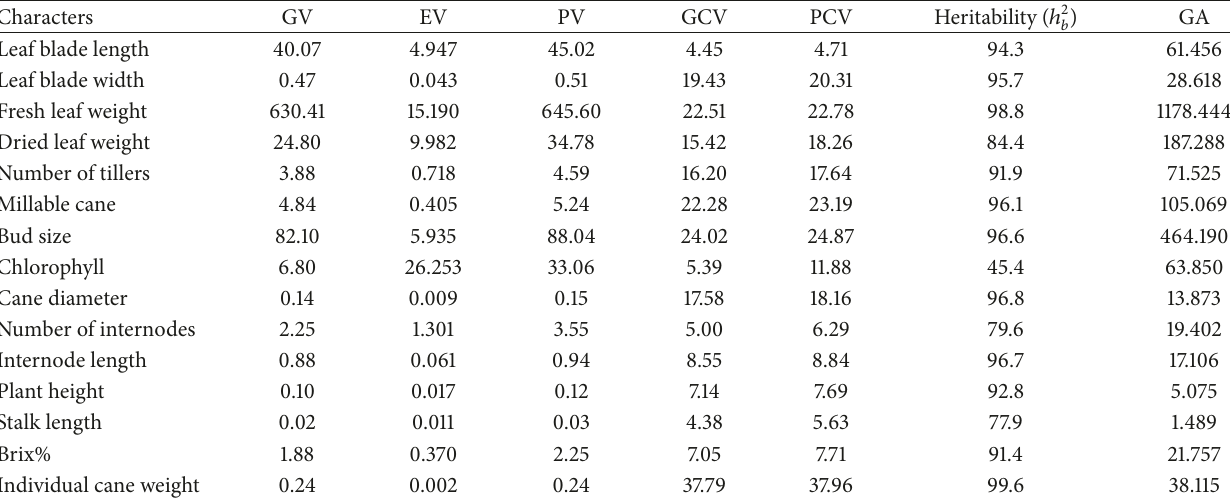
Table 2: Component for variances, heritability in broad sense ( ℎ 2 𝑏 ), and genetic advance (GA) for 15 variables of 9 exotic sugarcane genotypes .